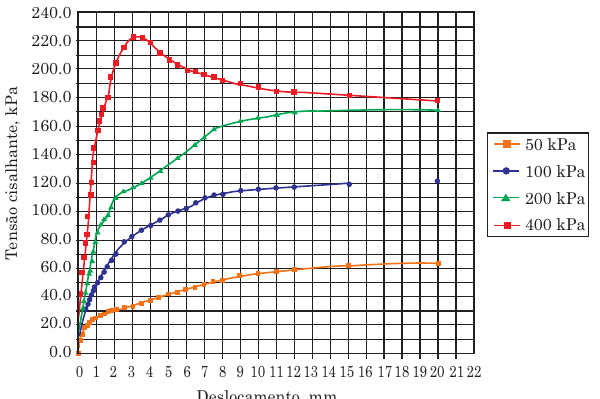
Figura 5. Tensão cisalhante x deslocamento horizontal para as amostras do talude com sete anos de plantio do capim